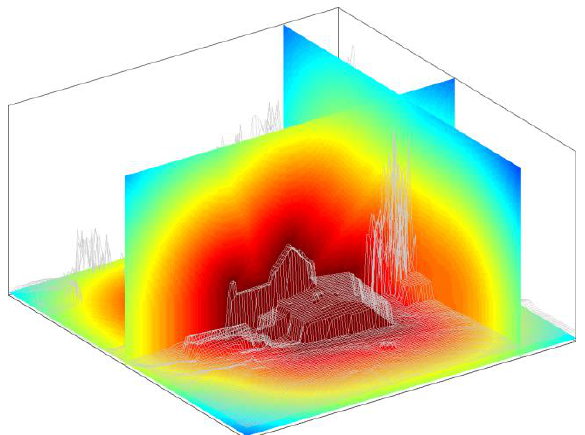
Figure 4. The volumetric map 𝑀 segments space into the classes object of interest (green), obstacle (red) and free space (blue). No-trespass areas 𝑁 create vertical obstacle areas. The DSM 𝐻 is indicated as grey mesh.